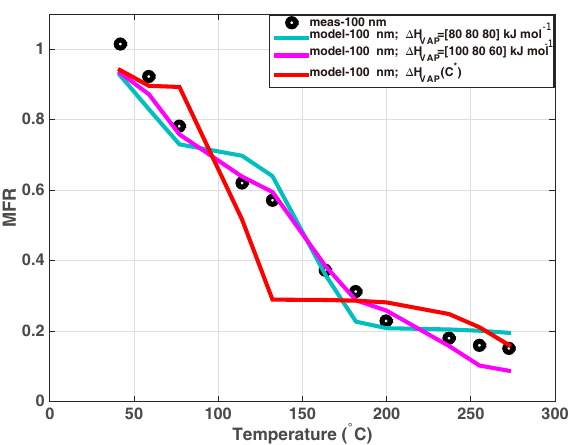
Figure 3. An example of measured (black dots) vs. modeled (green, magenta and red lines) thermograms assuming different vaporiza- tion enthalpies of the organics.